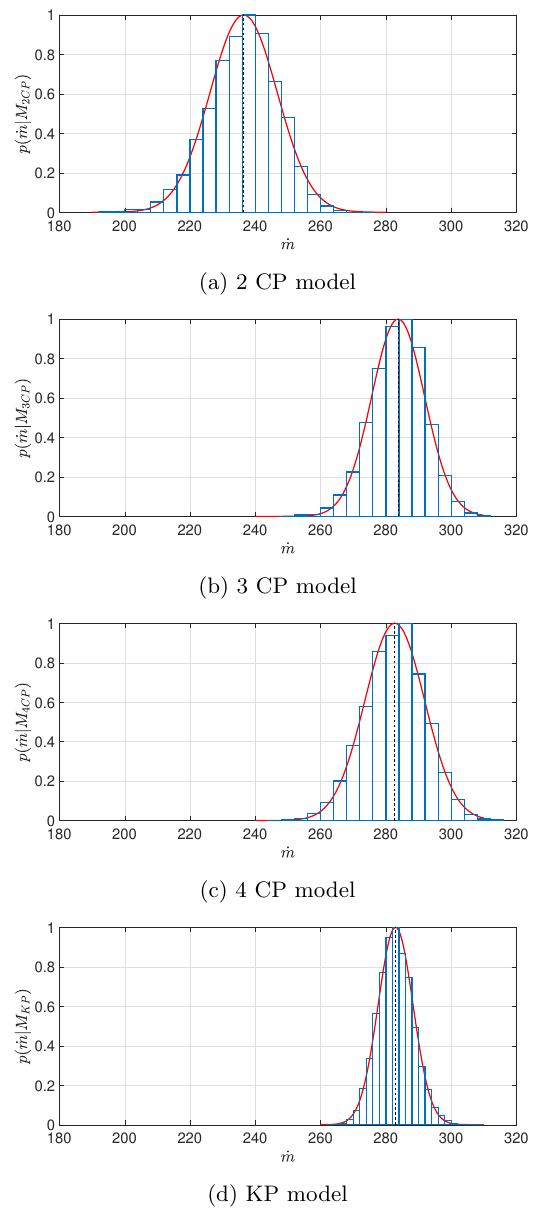
Figure 7: The probability distributions of the output mass flow rate ( p ( ˙ m | M )) for different models.